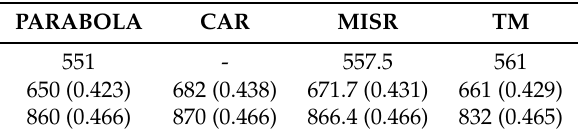
Table 1. Central wavelengths (in nm) relevant to PARABOLA for Cloud Absorption Radiometer (CAR) (1999–2011), Multiangle Imaging Spectroradiometer (MISR), and Thematic Mapper (TM) instruments. The weighed spectral reflectances SR (cid:48) in the red and NIR bands are given in parenthesis. PARABOLA CAR